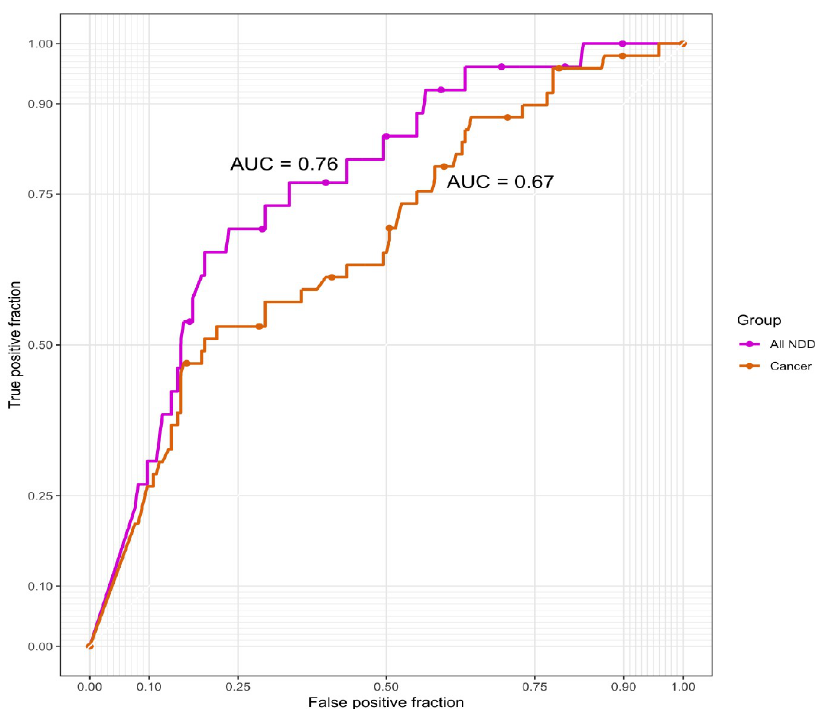
Fig 5. ROC Curve for Relative Accessible Surface Area as a Predictor of MTOR Variant Pathogenicity in Neurodevelopmental Disorders and Cancer. Receiver operating characteristic (ROC) curves were created for RSA in all neurodevelopmental disorder and cancer MTOR variants in comparison to population variants. AUC = area under the ROC curve.